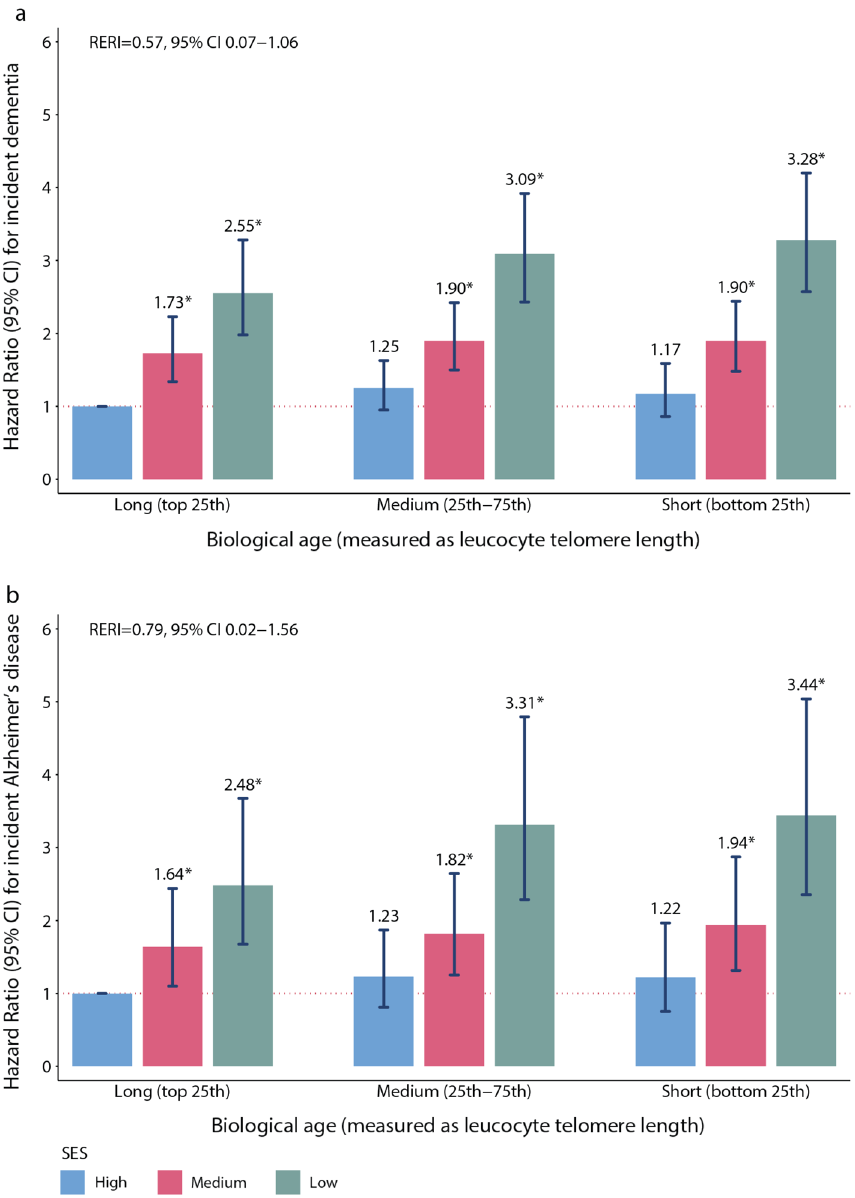
Figure 2. Joint associations of individual-level socio-economic status (SES) and adjusted residual leucocyte telomere length (LTL) with incident dementia and Alzheimer’s disease among UK Biobank participants. Analyses were performed based on data of 331,066 participants for ( a ) incident dementia and ( b ) incident Alzheimer’s disease. Models included age, sex, ethnicity, healthy lifestyle score, social activities, hearing difficulty, abdominal obesity, frailty index, urbanicity and neighbourhood deprivation. Residual of LTL, adjusted for chronological age, C-reactive protein and co-morbidities was defined as biological age in the study. The vertical bars indicate the hazard ratio, while the whiskers indicate the corresponding 95% confidence interval (CI). The asterisks represent statistically significant (two-sided p < 0.05) point estimates. Relative excess risk due to interaction (RERI) was used to examine additive interaction between SES (low SES versus high SES) and LTL (short LTL versus long LTL). See Supplementary Table S7 for detailed estimates, the corresponding 95% CI and calculations of